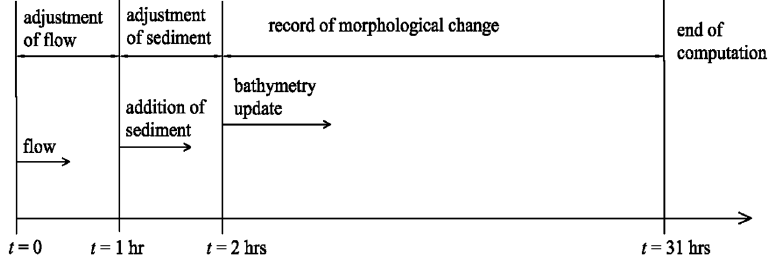
Figure 8. Schematic diagram of the coupled flow and sediment calculations.